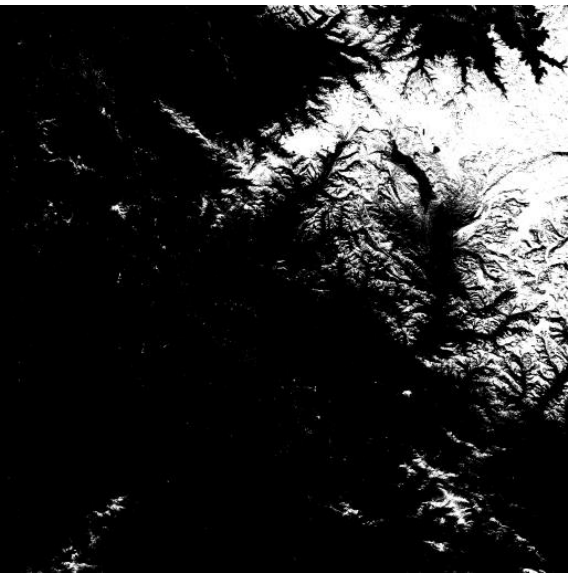
Figure 2. Ausangate Glacier ground truth dataset. In white: glacier extension; in black: rest of the scene (background).